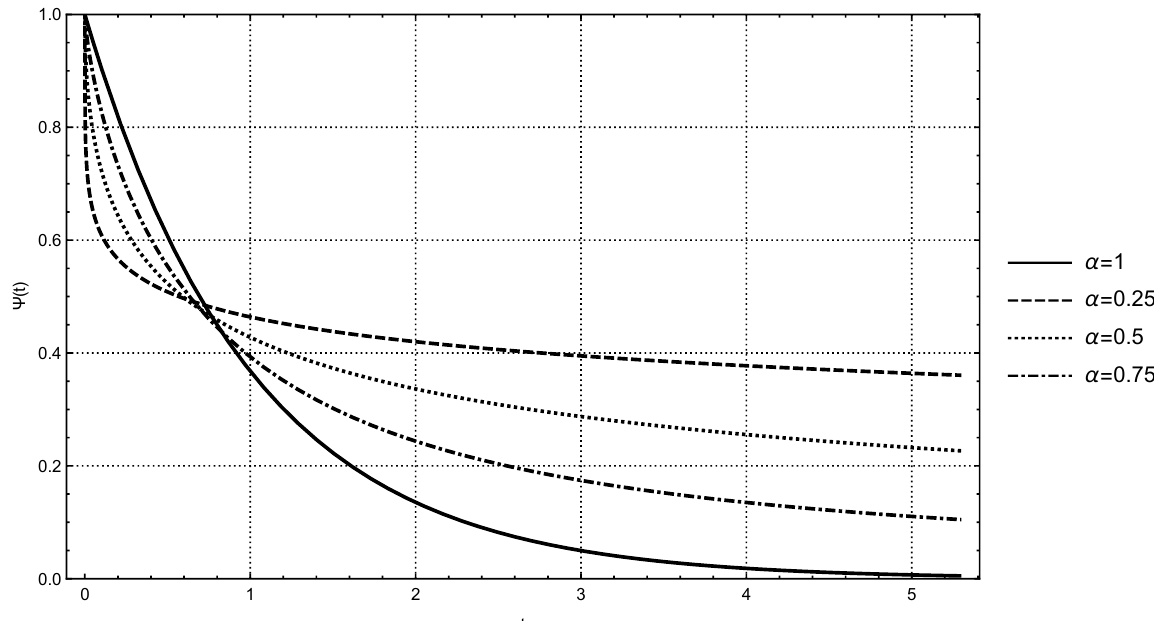
Figure 1. Plots of the Mittag–Leffler function Ψ α ( t ) for α = 0.25,0.50,0.75,1 versus t ∈ [ 0,5 ] .